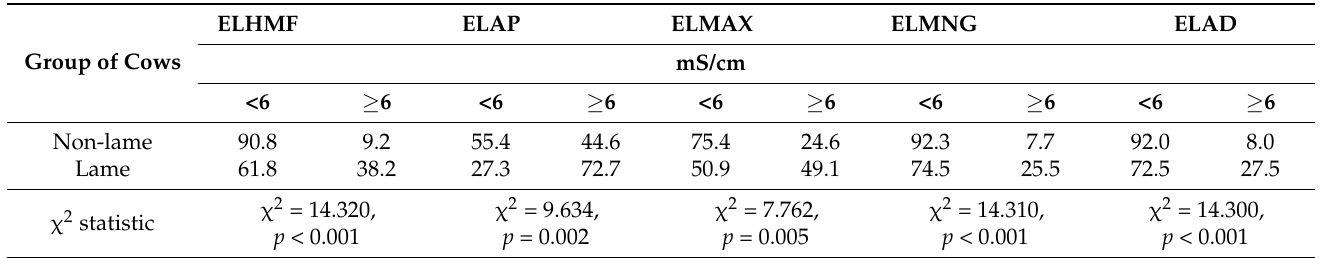
Table 2. The percentage of non-lame and lame cows based on milk electrical conductivity levels in different phases of milk flow.